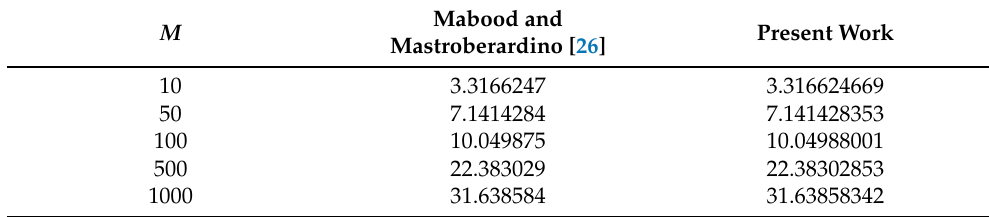
Table 2. Comparative outputs for skin-friction values Cf x Re 1 2 with the results of Mabood and Mastroberardino